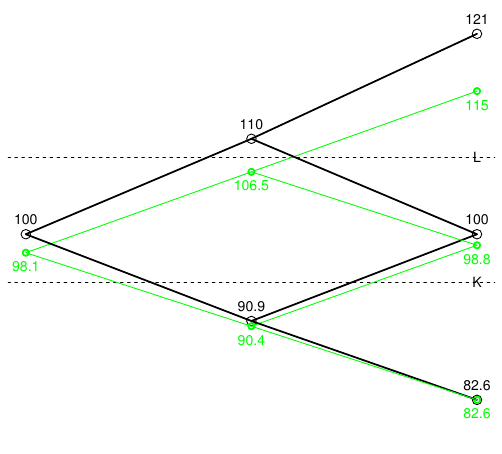
Figure 2. Trees of S ( t ) (black) and S W ( t )